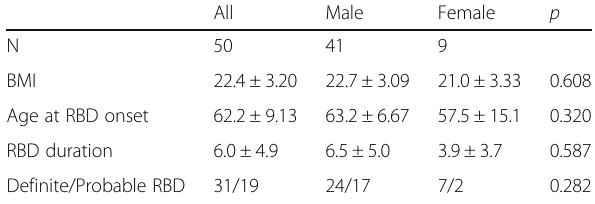
Table 1 Demographic data of the participants